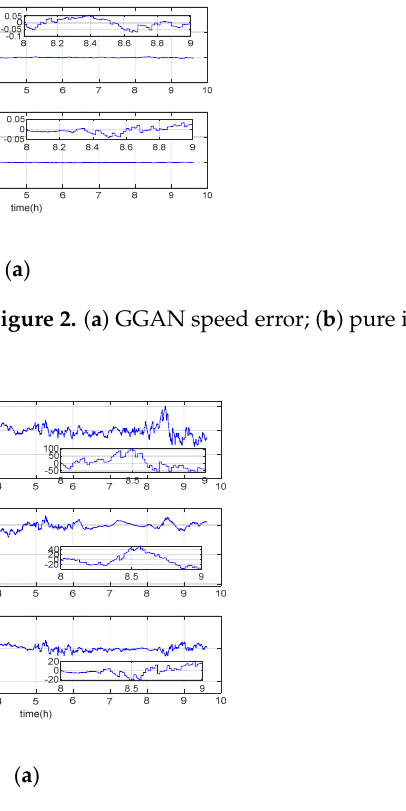
Figure 3. ( a ) GGAN position error; ( b ) pure inertial calculation position error.